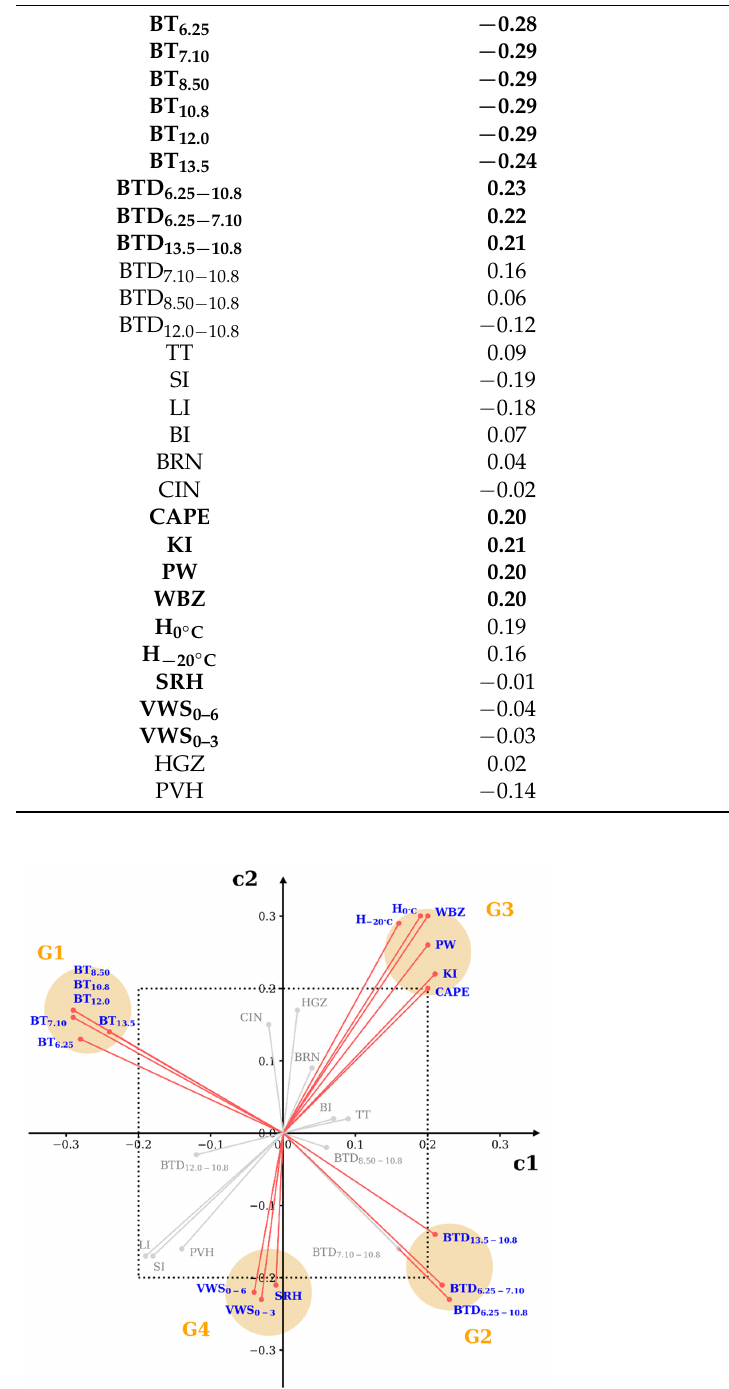
Figure 4. Biplot graph whose c1-axis and c2-axis represent the first and second PC coefficients. The projection on the c1-axis (c2-axis) reflects the magnitude and sign of each feature’s first (second) PC coefficient. The dotted box divides the selected and unselected features into two areas, where the vectors of selected (unselected) features are outside (inside) the box. Four yellow circular patches present four groups of selected features: G1 (BT group), G2 (BTD group), G3 (thermodynamic group), and G4 (dynamic group).